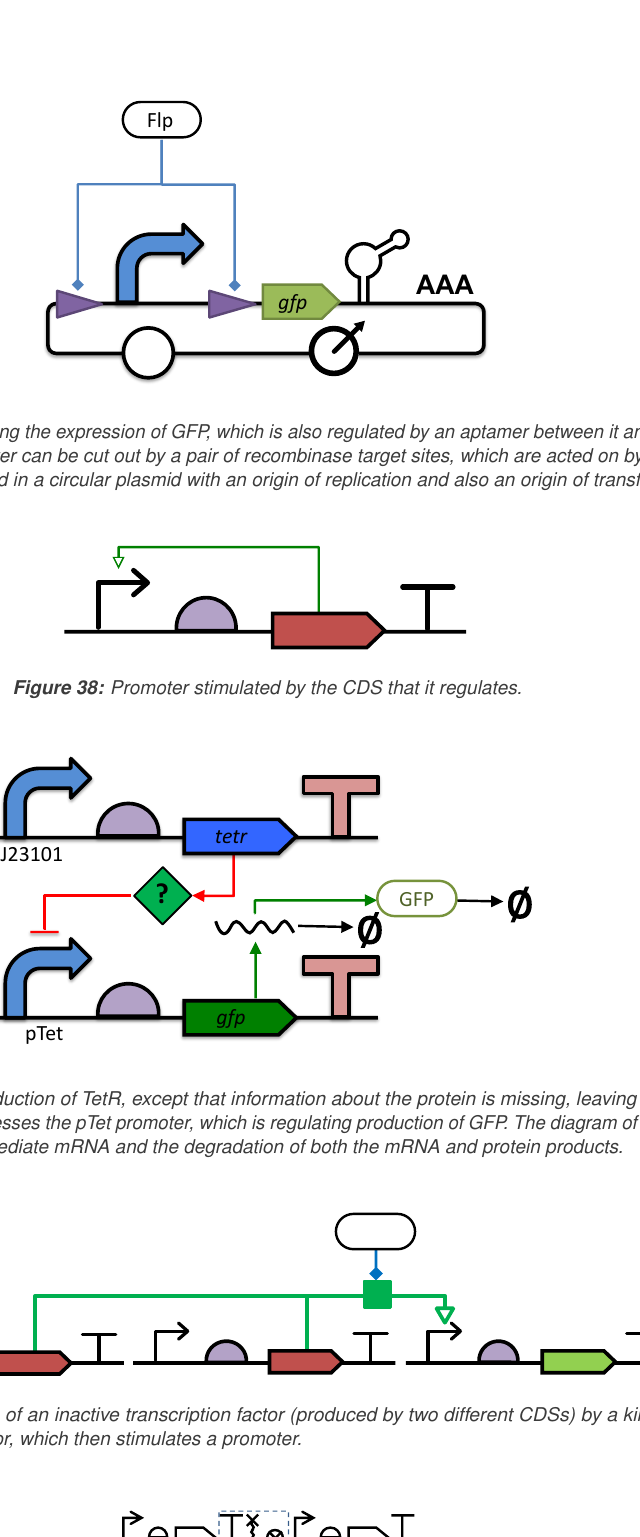
Figure 41: Ribozyme and spacer between two transcriptional units, forming a separation module with the preceding terminator (dashed box), with the whole construct integrated into the chromosome.